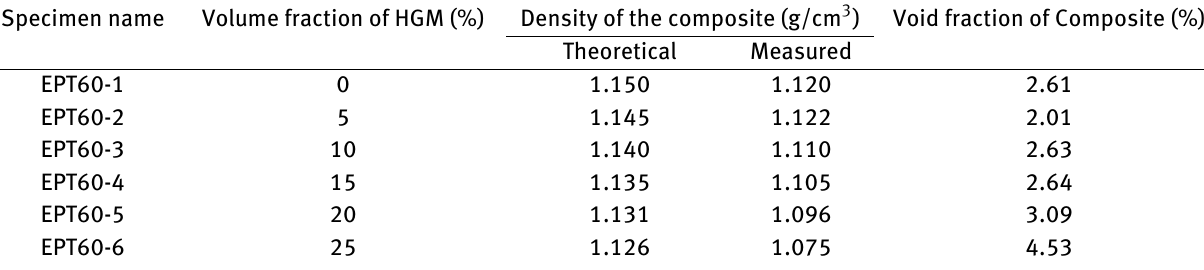
Table 1: The density and porosity (void) values of syntactic foam composites. Specimen